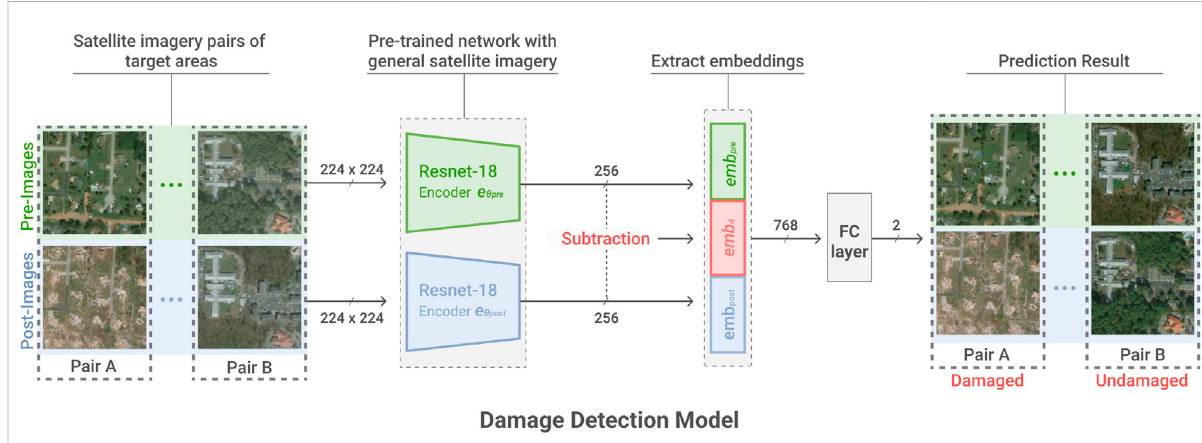
FIGURE 1 The overall work fl ow of the proposed model. Our damage detecting model takes pairs of pre- and post-disaster satellite images as inputs and classi fi es them into damaged pairs and undamaged pairs. We pre-trained the encoder with non-disaster satellite imagery before applying disaster satellite imagery. The pre-trained encoders extract embeddings from pre and post-disaster images of size 224×224, positioning them in a 256- dimensional space. For the fi nal classi fi cation, we used three embeddings: emb pre , emb post , emb d , where emb d is a subtraction of the fi rst two. The fully connected layer takes them as input and predicts the binary label of each pair. The resulting binary label is assigned for each grid with asize of 0.093 km 2